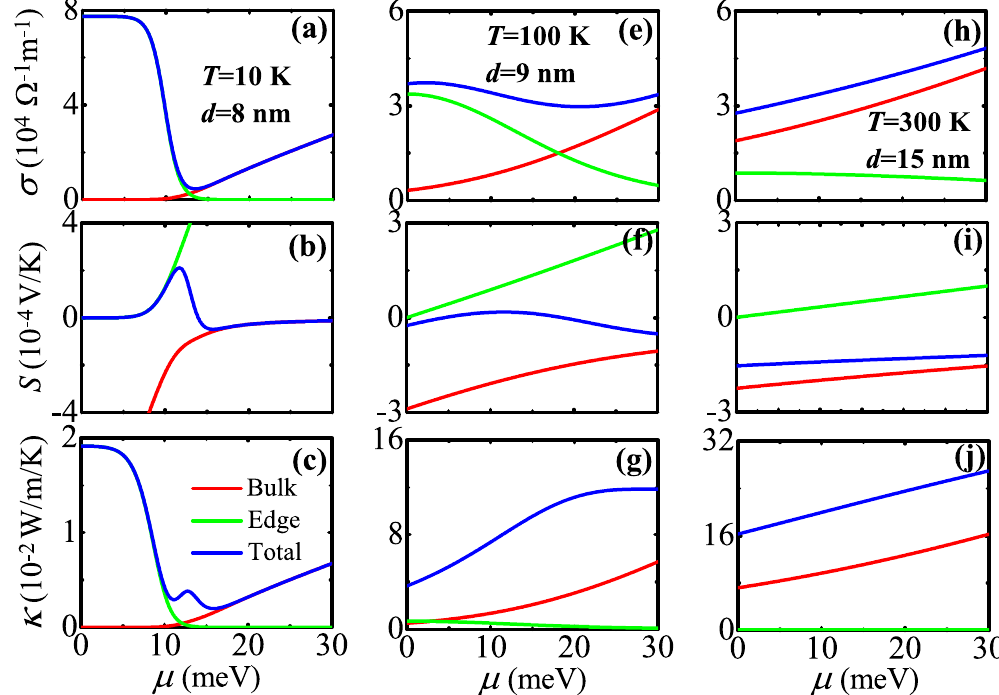
Figure 3. Electric conductivity, Seebeck coefficients, and electron thermal conductivity as a function of the chemical potential for various QWs in the TI regime at different temperatures, where ( a )~( c ) plot the results for T = 10 K and d = 8 nm, ( e )~( g ) for T = 100 K and d = 9 nm, and ( h )~( j ) for T = 300 K and d = 15 nm. Here, the black dashed line represents the bulk band-edge, the red and green solid lines represent the edge-state and bulk- state contributions to the TE transport, respectively, and the blue solid line represents the total TE